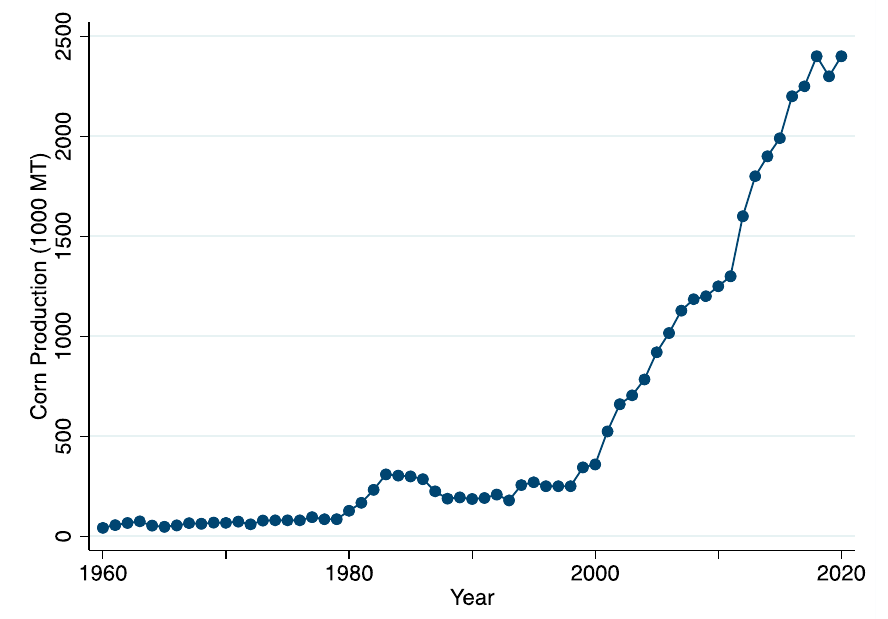
Figure 5. Myanmar maize production by year 2 .